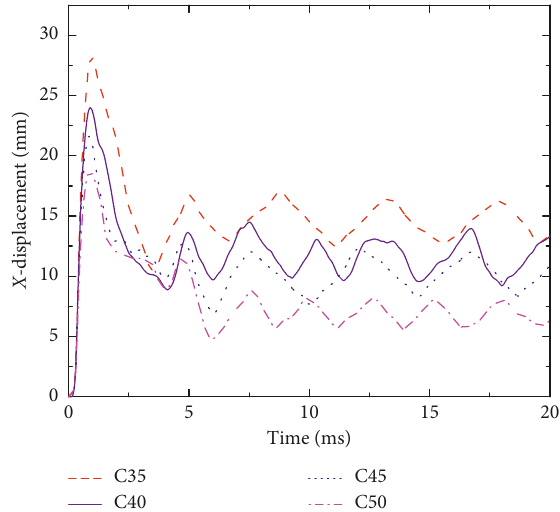
Figure 21: Comparison of midheight displacement with different comprehensive strengths of